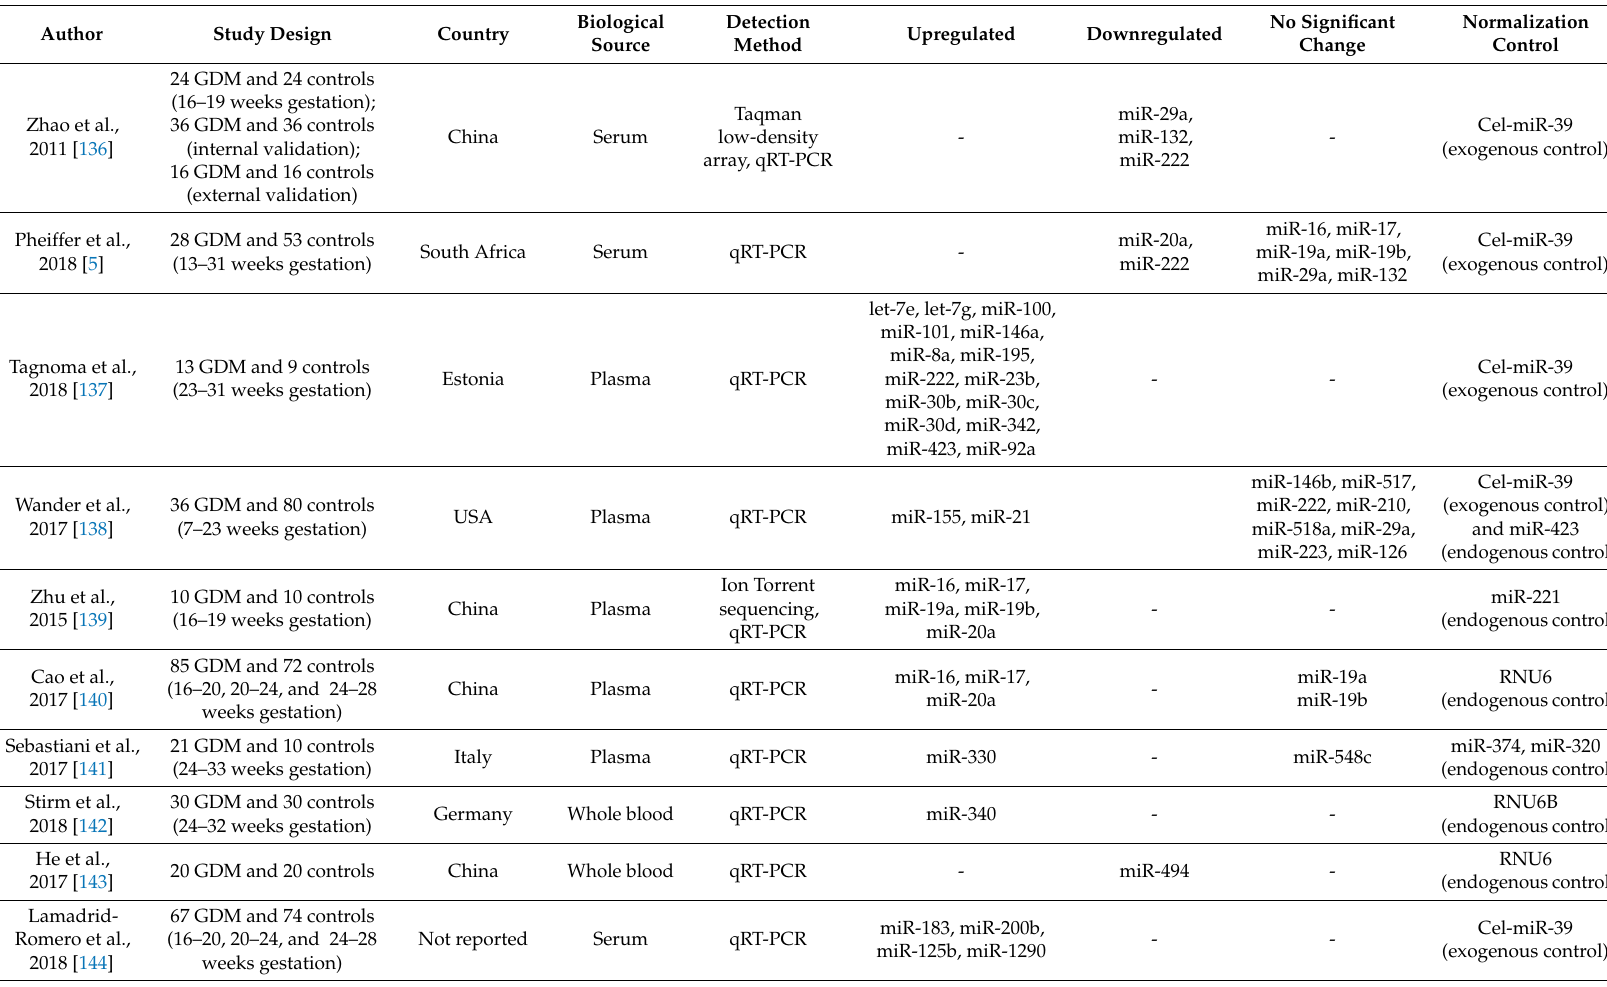
Table 3. Studies investigating circulating microRNAs (miRNAs) during gestational diabetes